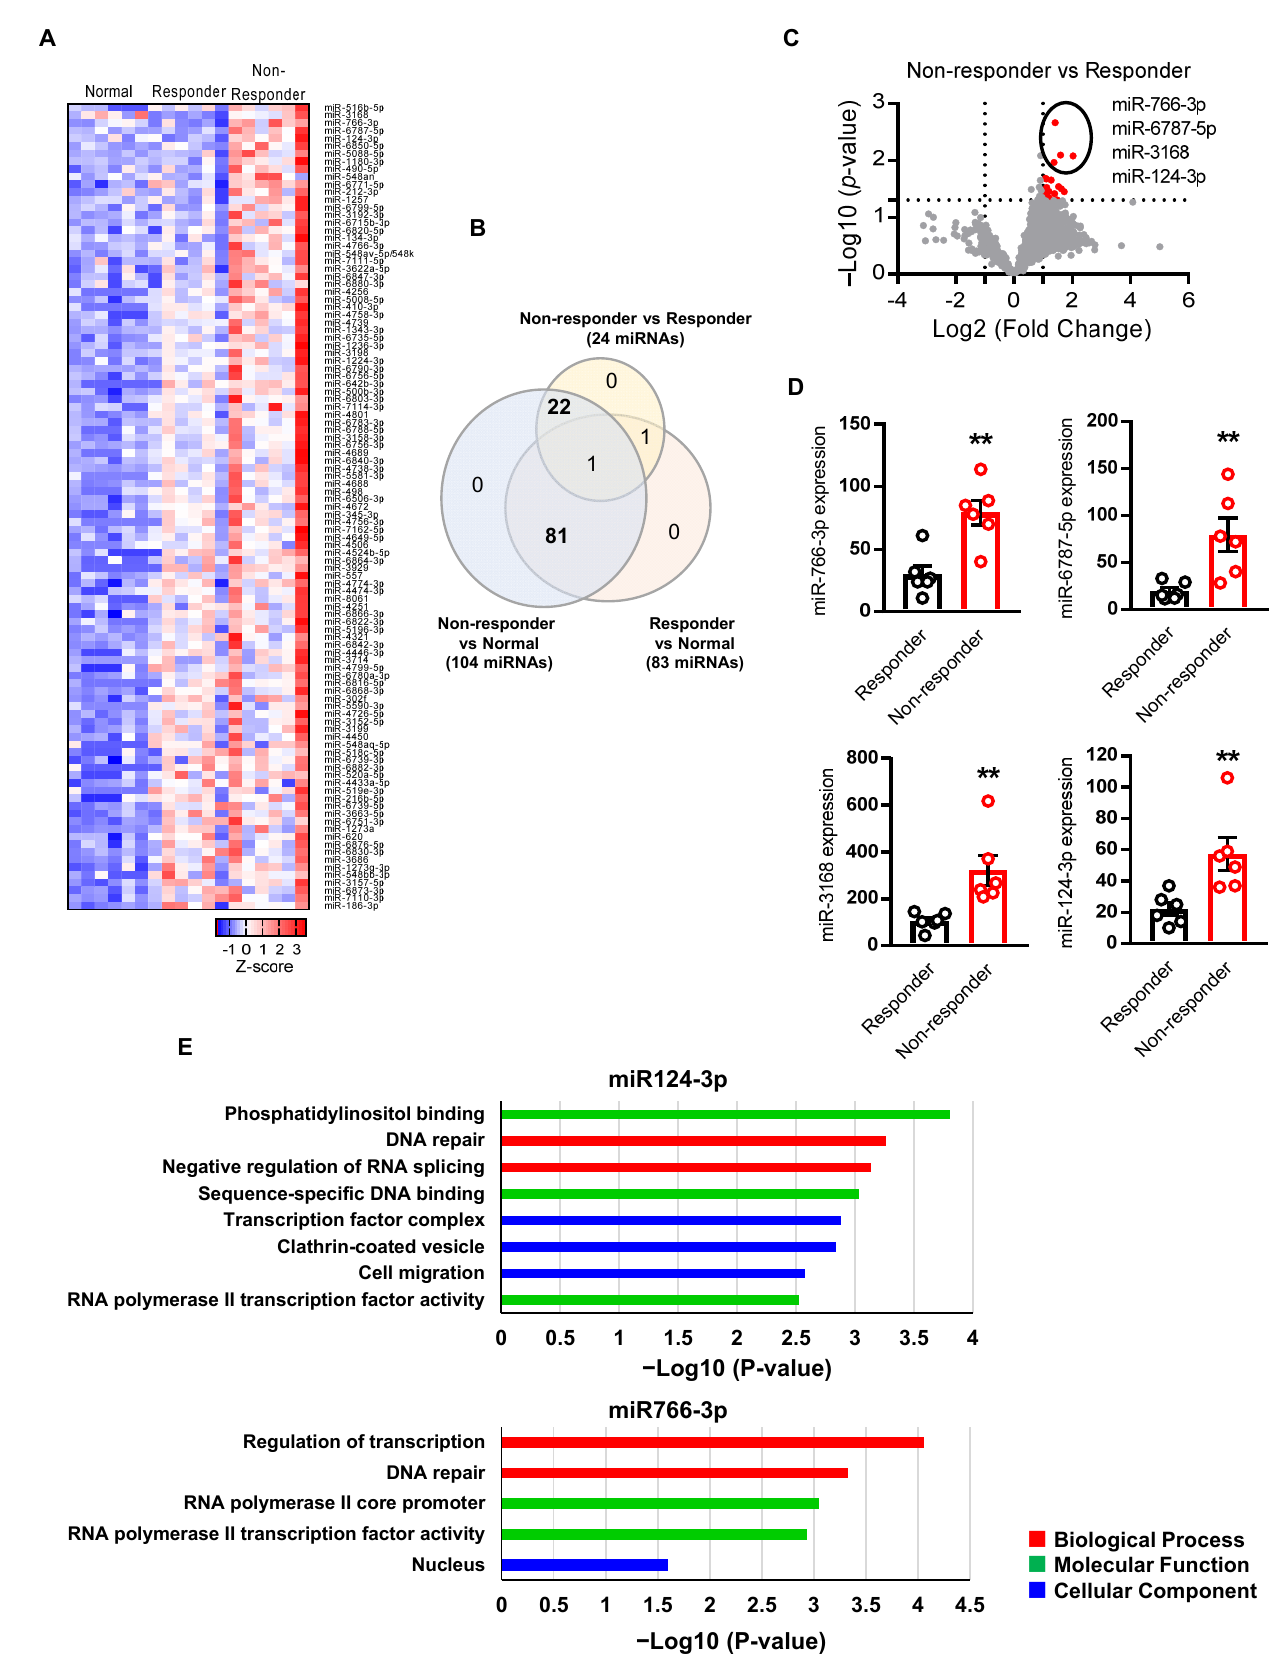
Figure 1. Identification of miRNA associated with HNSCC resistance. ( A ) Heatmap